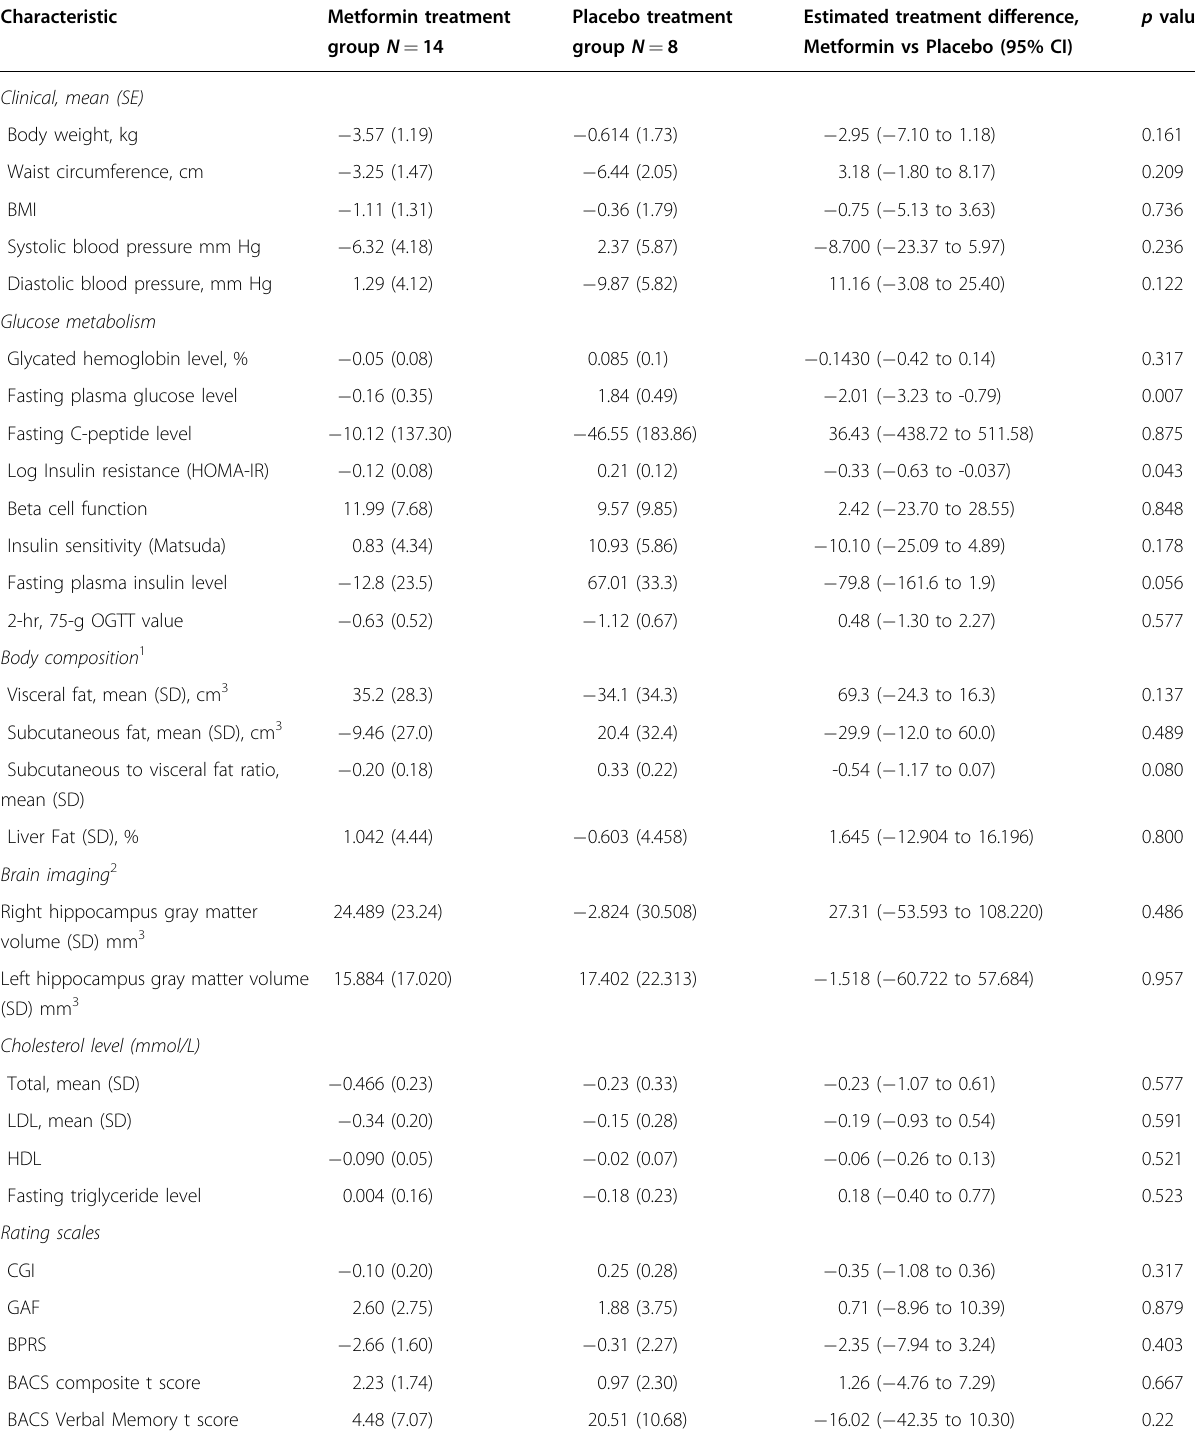
Table 2 Change in outcome measures from Baseline to Week